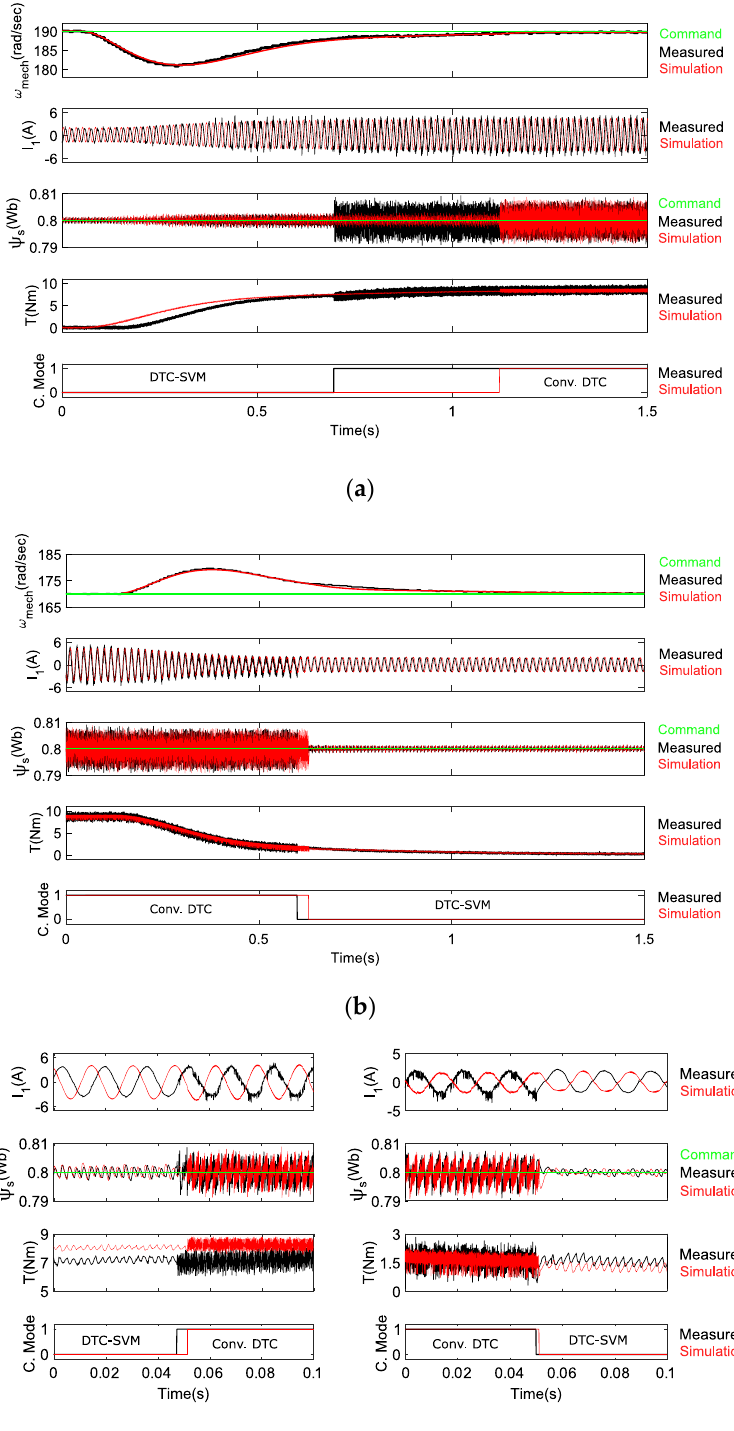
Figure 21. Transition between control modes at constant speed: ( a ) whole operation region for an increase on the load, ( b ) whole operation region for a reduction on the load, ( c ) zoom at the transition for an increase on the load and ( d ) zoom at the transition when the load is reduced.